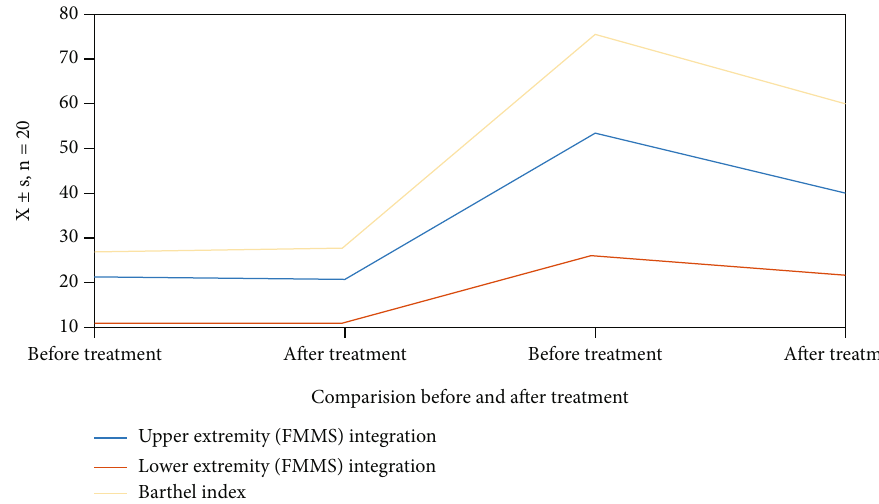
Figure 5: Comparison of the functions of the two groups before and after treatment ( x ± s , n = 20 ).